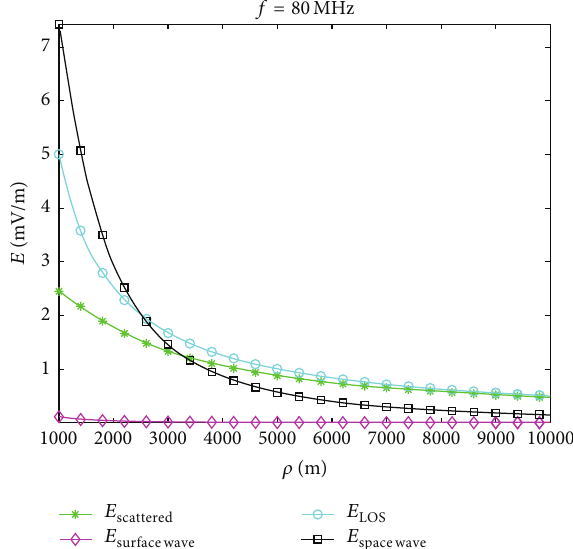
Figure 4: Similar to Figure 3, except that here the frequency of radiatingHertziandipoleisnowequalto30 MHz(lowerfrequency). In this case of lower frequency, the “surface wave” cannot be considered negligible, as compared to the “space wave”